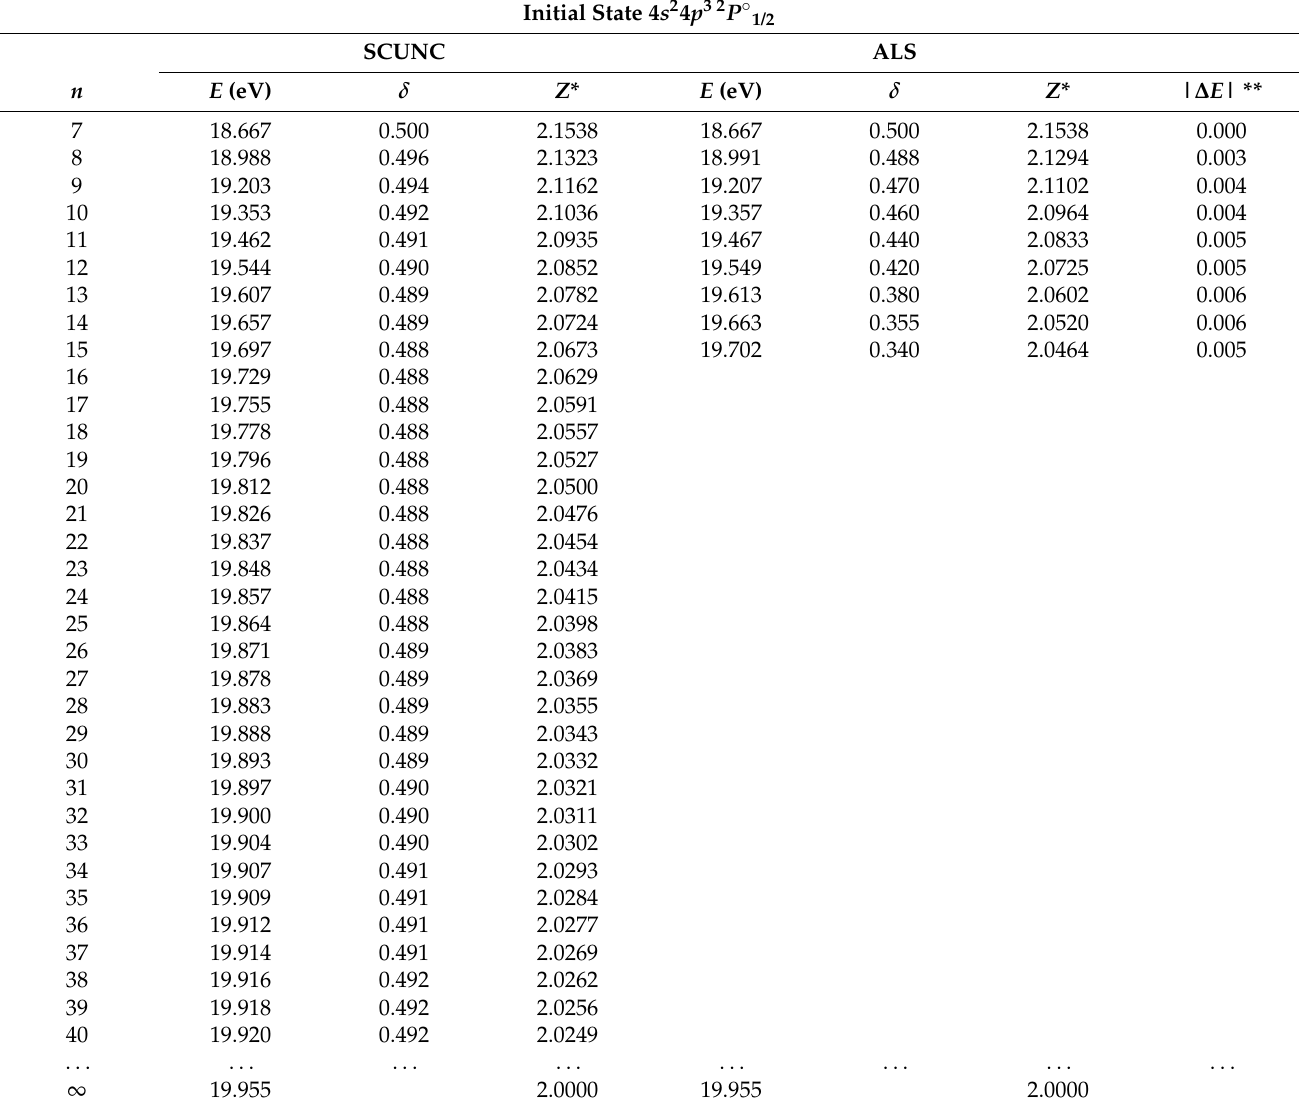
Table 8. Energy resonances ( E ), quantum defect ( δ ) and effective charge ( Z *) of the 4 s 2 4 p 2 ( 1 D 2 ) ns Rydberg series originating from the 4 s 2 4 p 3 2 P ◦ 1/2 metastable state of Se + converging to the 1 D 2 series limit in Se 2+ . The present results (SCUNC) are compared with the experimental data from ALS measurements [6]. The uncertainties in the experimental energies are stated to be ± 0.010 eV, f 1 ( 1 D 2 ; 2 P ◦ − 0.923 ± 0.050 with ν = 1/2 ) =